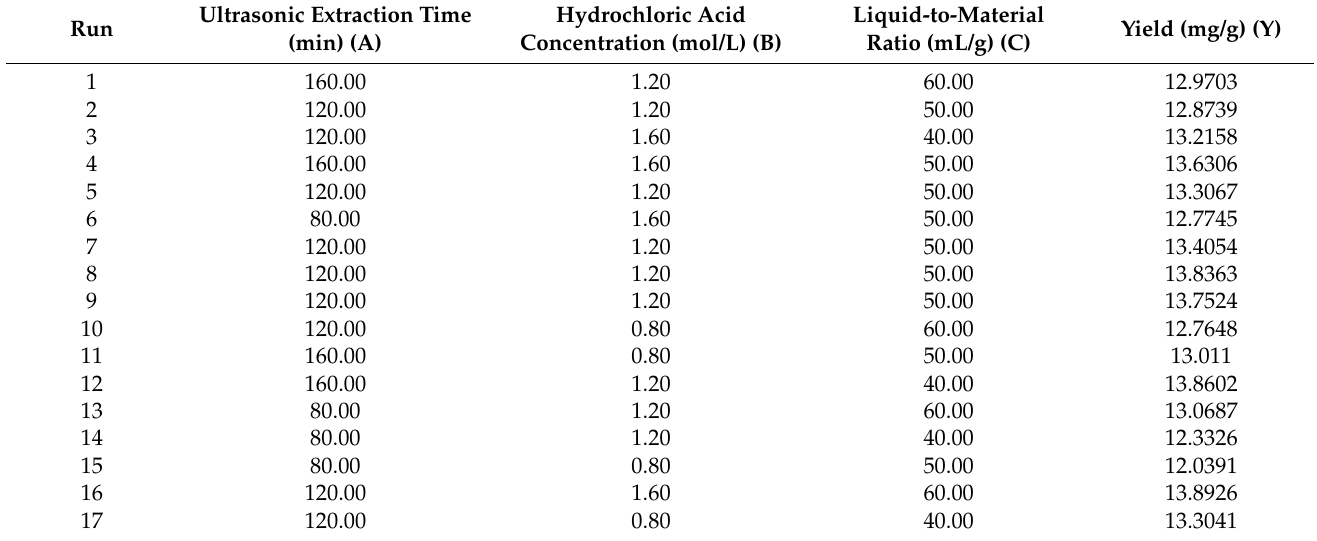
Table 3. BBD trial design and results.